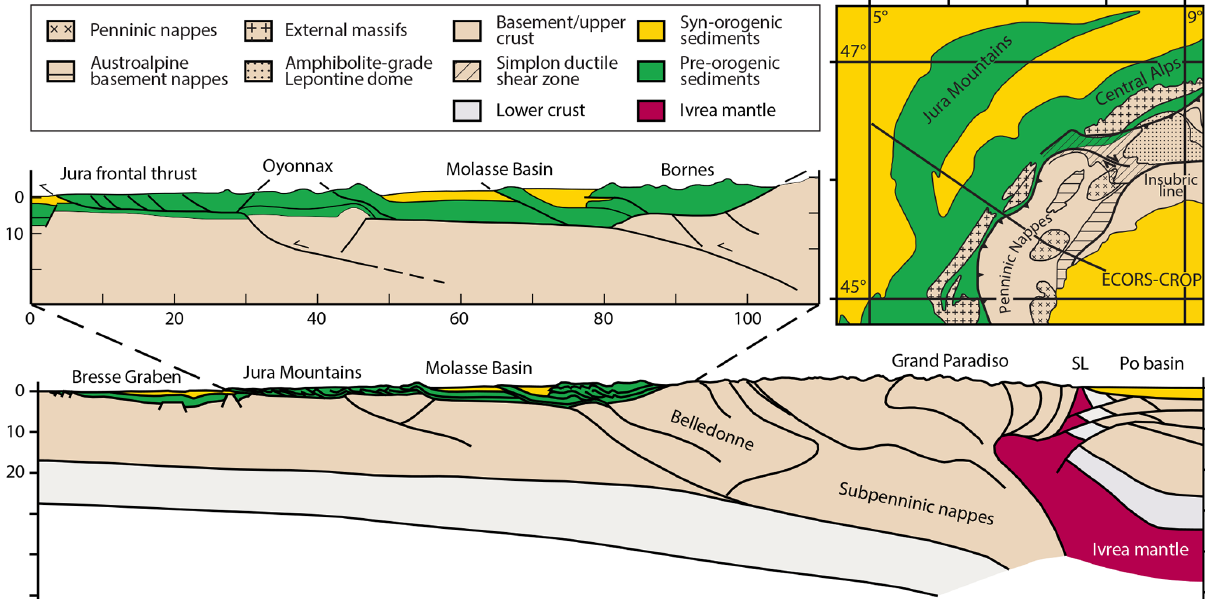
Figure 1. Cross section and geological map of the Western Alps, redrawn after Schmid and Kissling (2000) and Schmid et al. (2017), with the inset showing the section interpretation of Roure (2008) along part of the same deep seismic section. SL indicates the location of the Sesia–Lanzo zone.